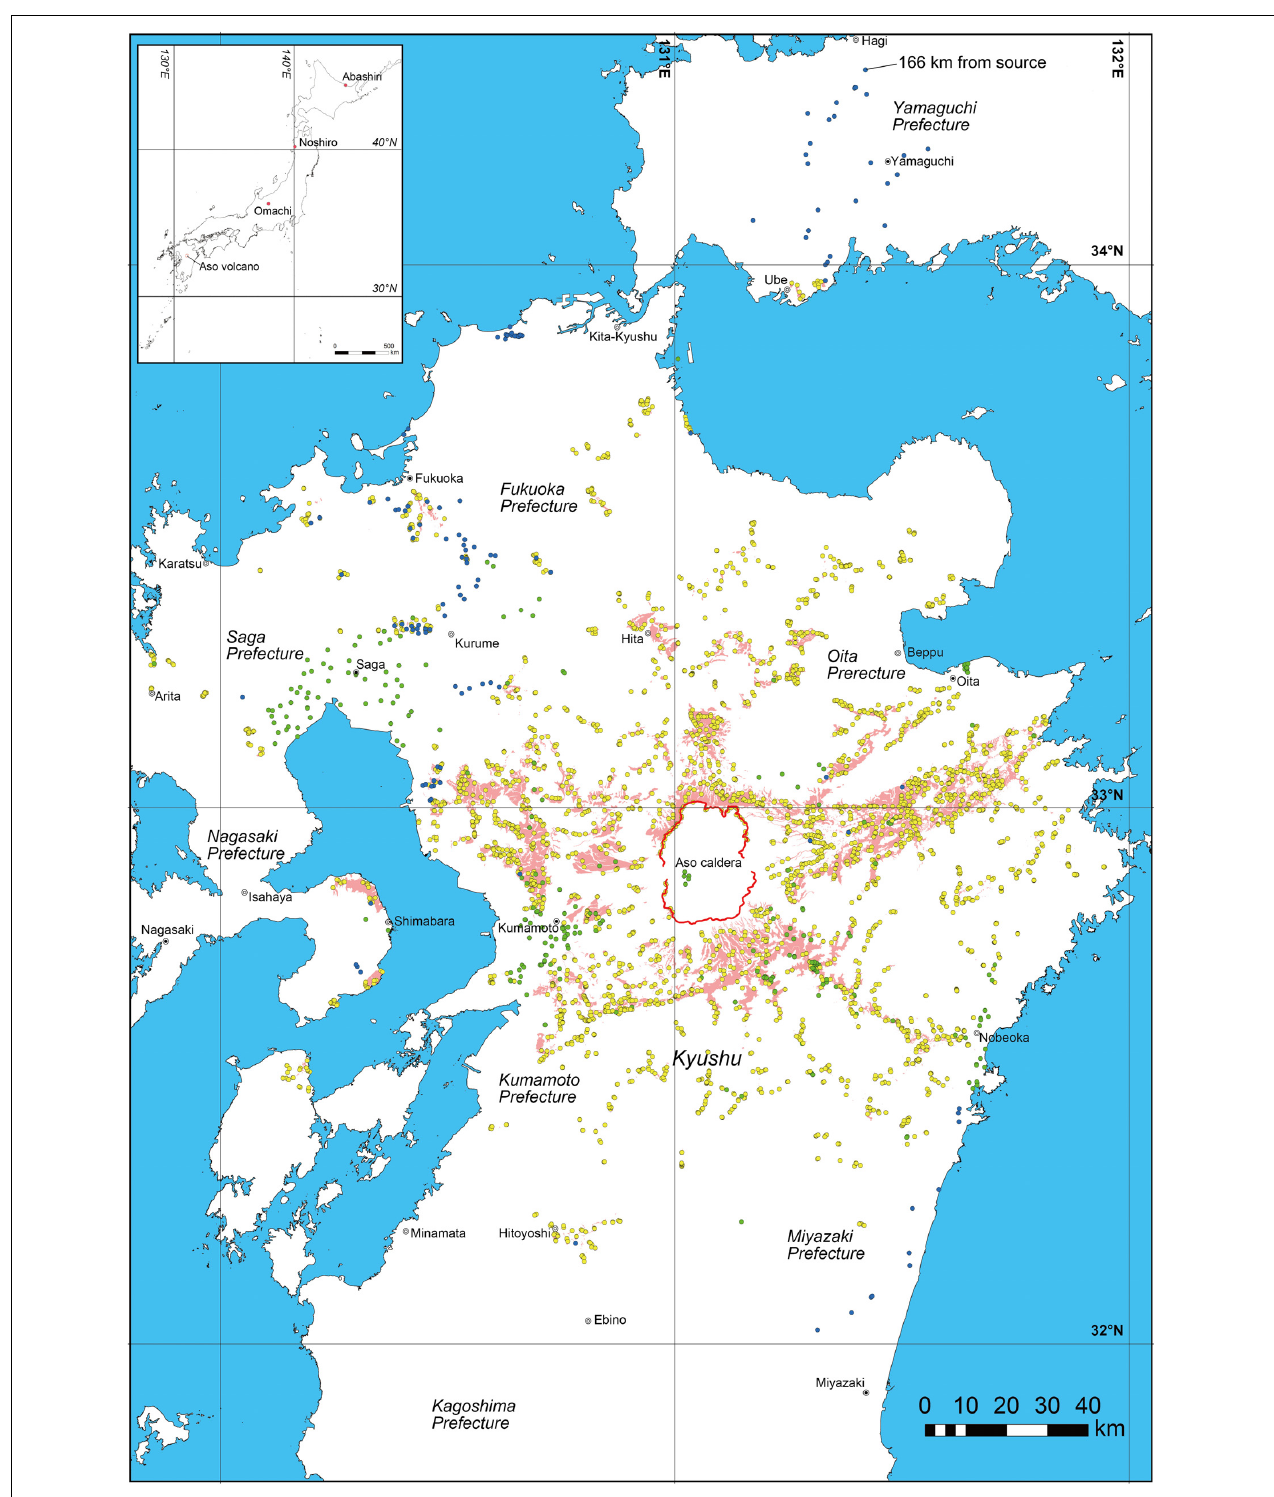
FIGURE 1 | Distribution of current Aso-4 PDC deposit exposures (orange-colored part) and Aso caldera (red line). Circles on the map indicate locations to measure the thickness of PDC deposits based on outcrops (blue circle), borehole (green circle), and topography (yellow circle) sites. The outcrop located at 166 km from the source is shown. The tephra fall outcrop locations at Omachi City, Nagano Prefecture, Noshiro City, Akita Prefecture, and Abashiri City, Hokkaido, are shown in the inset map (upper left corner).